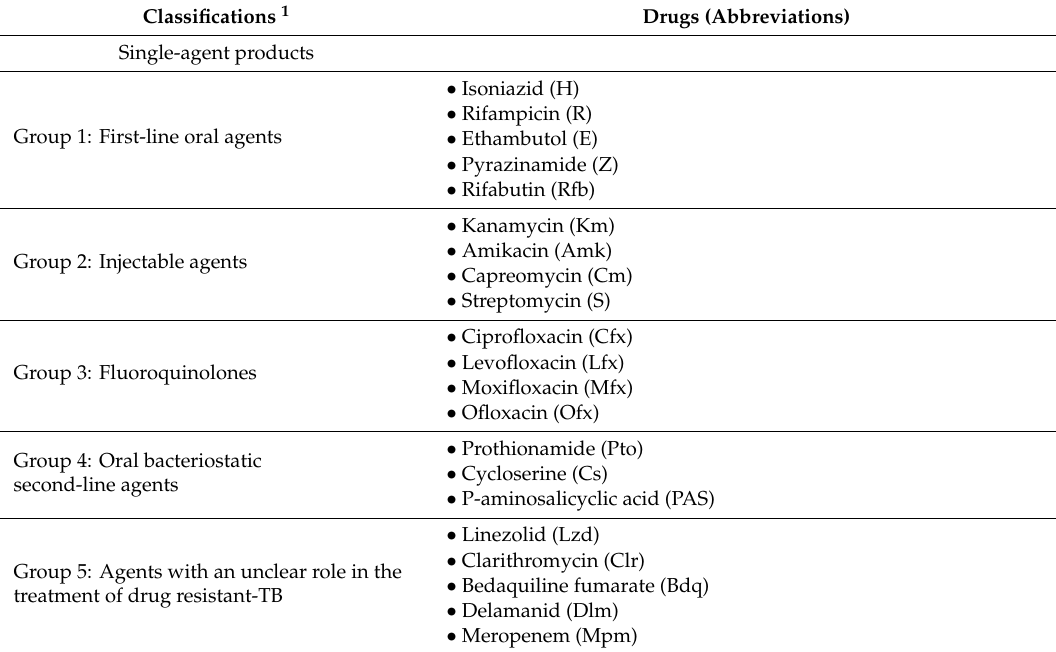
Table A1. List of the anti-tuberculosis drugs selected for this